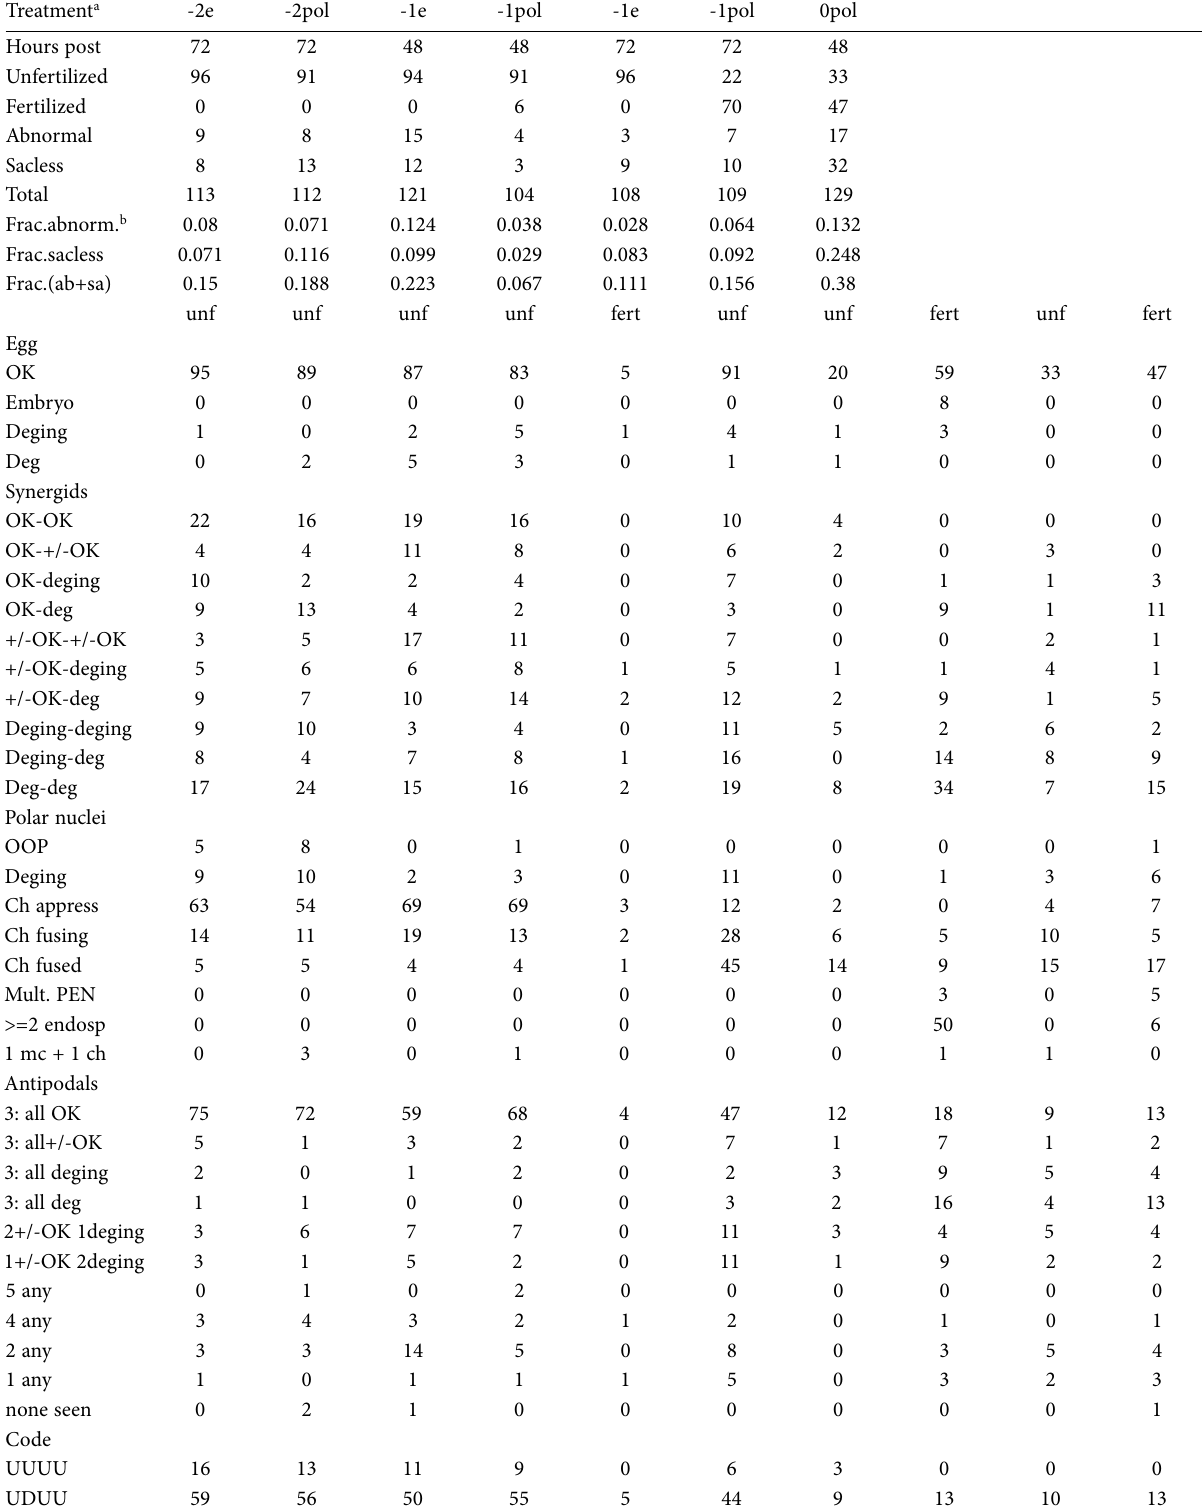
Table 2. Classification of Z. chlorosolen embryo sacs and their components, merged by time of emasculation, pollination, and